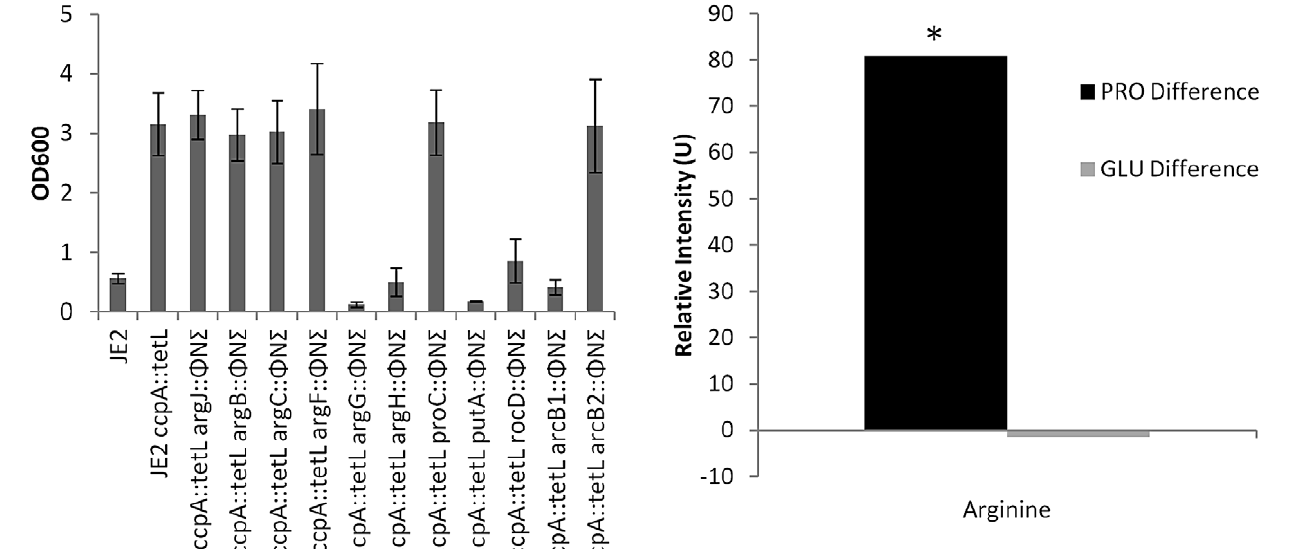
Figure 6. Two-dimensional (2D) 1 H- 13 C heteronuclear single quantum coherence (HSQC) nuclear magnetic resonance (NMR) analysis of JE2 and JE2 ccpA::ermB . JE2 and JE2 ccpA::ermB were grown in the presence of 13 C 5 -glutamate or 13 C 5 -proline in CDM and CDM-R, respectively, and assayed using 2D 13 C HSQC NMR. The differences in 13 C-arginine relative intensity were determined by subtracting the average intensities between JE2 and JE2 ccpA::ermB , and a student’s t-test was utilized to determine significance. A positive relative intensity value is indicative of a greater intensity of 13 C-arginine in JE2 ccpA::ermB in comparison to JE2. JE2 ccpA::ermB accumulated significantly greater amounts of 13 C-arginine when grown in CDM containing 13 C 5 -proline in comparison to JE2. Note that there was no significant difference in 13 C-arginine accumulation between JE2 and JE2 ccpA::ermB when grown in CDM and CDM-R, respectively,